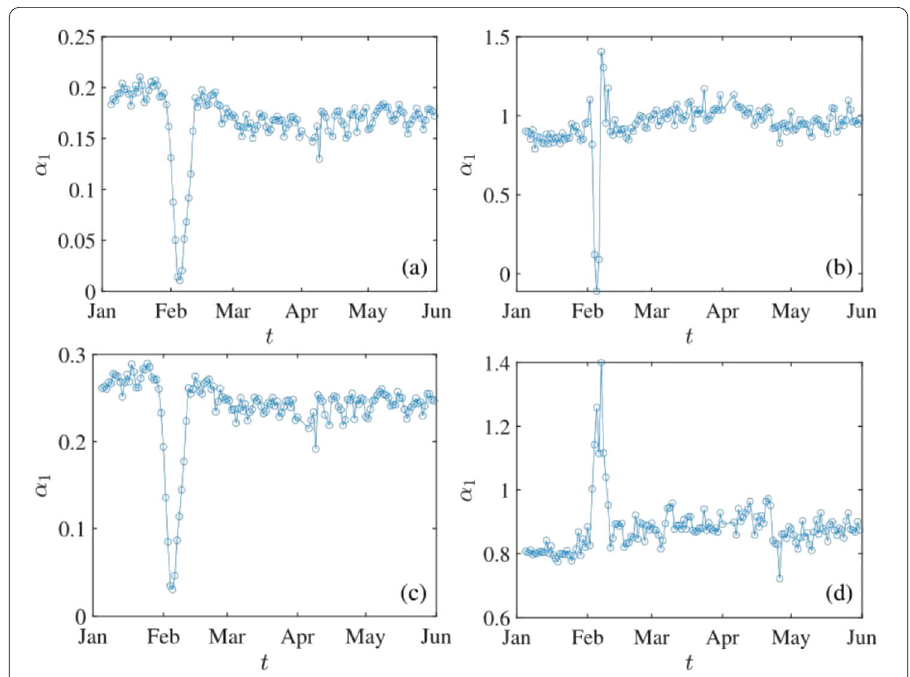
Figure 3 Evolution of the exponents α 1 of daily directed and undirected freight highway transportation networks. ( a ) Scatter data of F ij with respect to G i G j / d 2 for the directed network. ( b ) Binning data of F ij with ij respect to G i G j / d 2 ij for the directed network. ( c ) Scatter data of W ij with respect to G i G j / d 2 ij for the undirected network. ( d ) Binning data of W ij with respect to G i G j / d 2 ij for the undirected